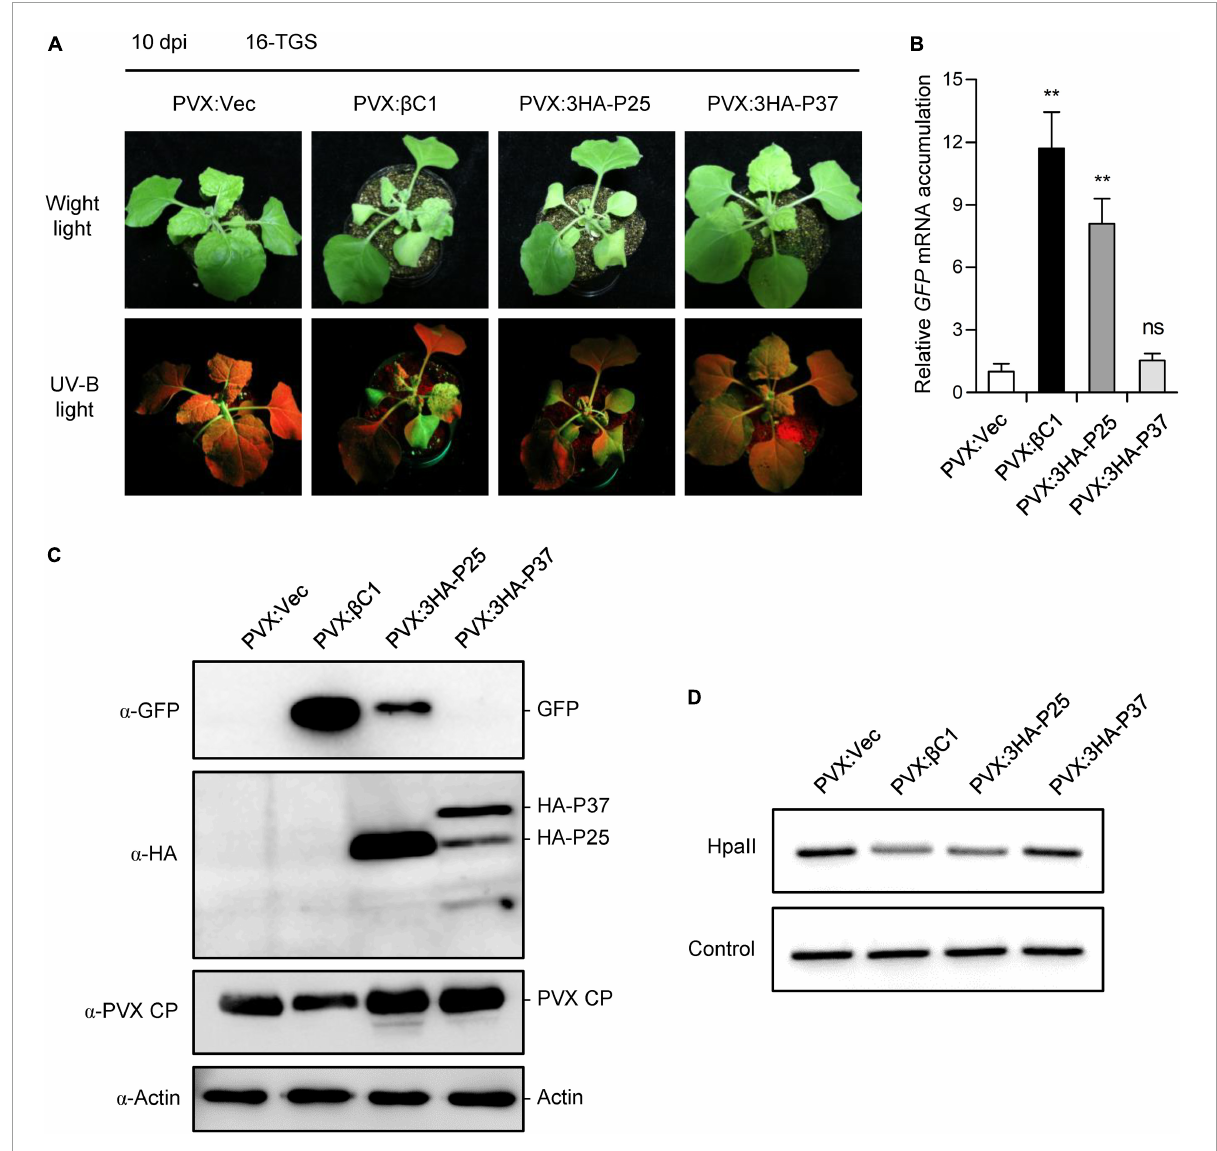
FIGURE6 Firespike leafroll-associated virus (FLRaV) P25 and P37 can inhibit the transcriptional gene silencing (TGS) of green fluorescent protein (GFP) in 16-TGS Nicotiana benthamiana . (A) 16-TGS N. benthamiana seedlings were agroinfiltrated with an empty PVX vector (PVX:Vec), PVX: β C1, PVX:3HA-P25, or PVX:3HA-P37, and the seedlings at 10 days post infiltration (dpi). 16-TGS seedlings agroinfiltrated with PVX:Vec and PVX: β C1 were served as the negative and positive controls, respectively. (B) Quantitative real time PCR (qRT-PCR) analysis of the accumulation of GFP mRNA in systemic leaves shown in (A) . NbACT2 was used as the internal control. Data are presented as means ± SD of three biological replicates. Means with asterisks are significantly different (Student’s t -test; P < 0.05). ns, not significant. (C) Western blot (WB) analysis of the accumulation of GFP protein in systemic leaves shown in (A) . GFP, HA-P25, HA-P37, and PVX CP were detected using antibodies to GFP ( α -GFP), HA tag ( α -HA), and to PVX-CP ( α -PVX-CP), respectively. WB analysis of actin using an α -Actin was served as the loading control. (D) Chop-PCR analysis of the DNA methylation of the 35S promoter in 16-TGS. Genomic DNA was isolated from systemic leaves shown in (A) . Samples extracted from 16-TGS seedlings agroinfiltrated with PVX:Vec was served as the negative